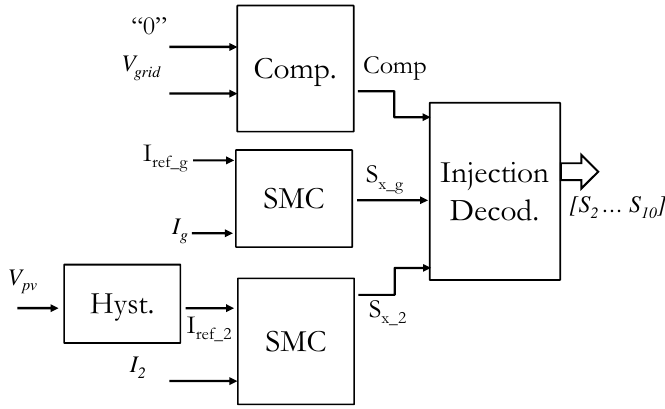
Figure 14. Block diagram of the control strategy of the injection of current into